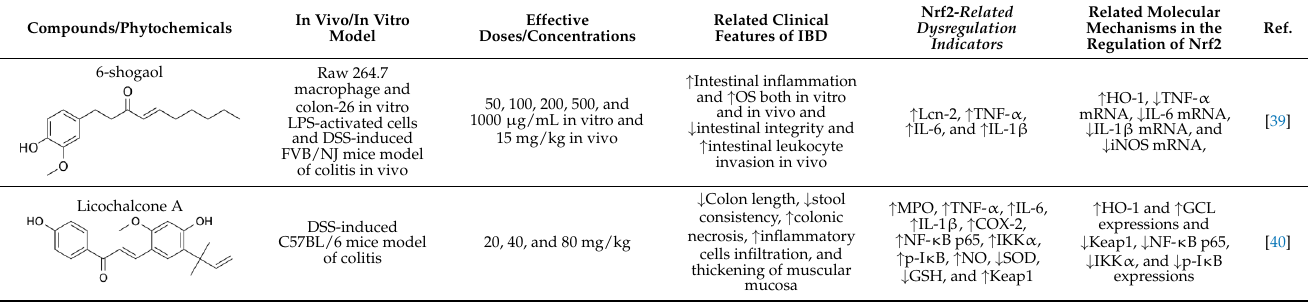
Table 2. List of natural and synthesized phytochemicals with regulatory effects on (Nrf2) signaling pathways in IBD.